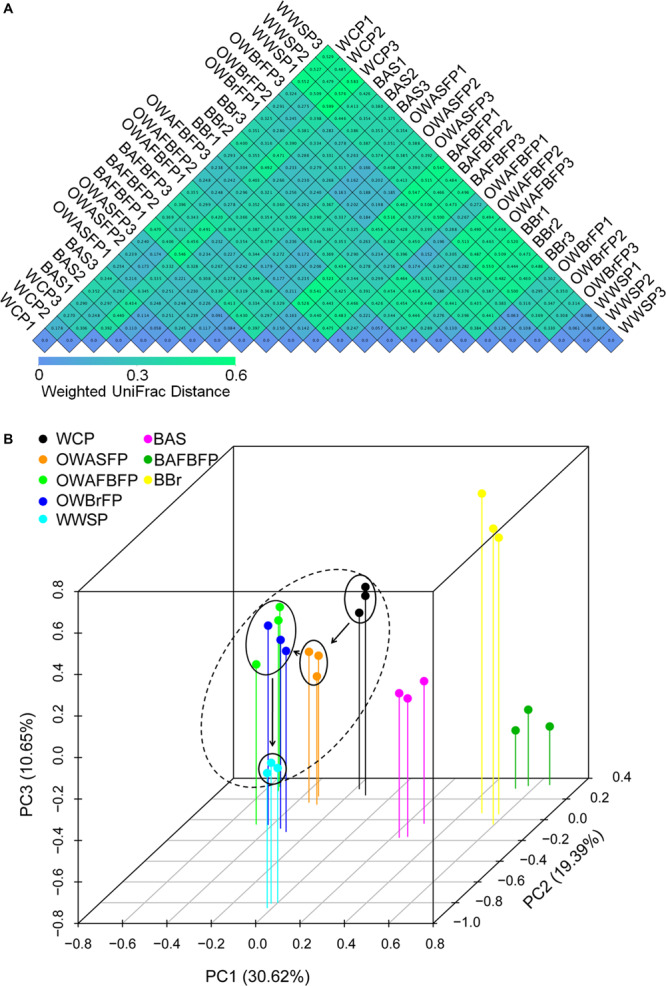
Heatmap showing weighted UniFrac distances (A) and redundancy analysis (RDA) profile (B) of microbiota OTU compositions in the different sections of the field-scale aquaculture wastewater treatment system (FAWTS). BAFBFP, biofilms from the artificial floating bed filtering pond; BAS, biofilms from the artificial substrates; BBr, biofilm from the brush filtering pond; OWAFBFP, outfall water from the artificial substrate floating bed filtering pond; OWASFP, outfall water from the artificial substrate filtering pond; OWBrFP, outfall water from the brush filtering pond; WCP, water from culture ponds; WWSP, water from the storage pond. Dotted circles indicate microbial samples from water habitats. Solid arrows indicate the direction of water flow in the FAWTS.